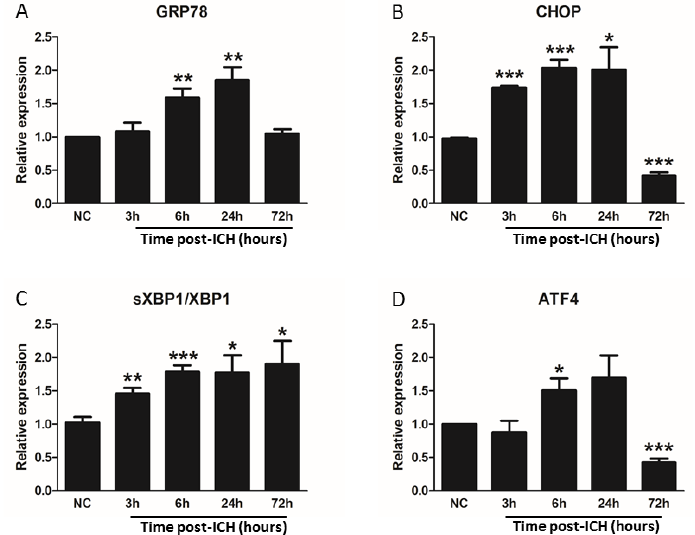
Figure 6. ICH induced the protein degradation of GRP78 and IκB protein. Representative Western blotting analysis of striatal tissue lysates immunoprecipitated with anti-glucose-regulated protein 78 kDa (GRP78) ( A ) and anti-IκB ( C ) antibodies followed by anti-ubiquitin antibody at normal (NC), 3 (ICH-3h), and 72 h (ICH-72h) post-ICH injury. Value of quantitative of relative ubiquitinated GRP78 ( B ) and I κ B ( D ) are indicated by means ± SEM; n = 4 each group, * p < 0.05; *** p < 0.001; compared to the normal group, respectively.